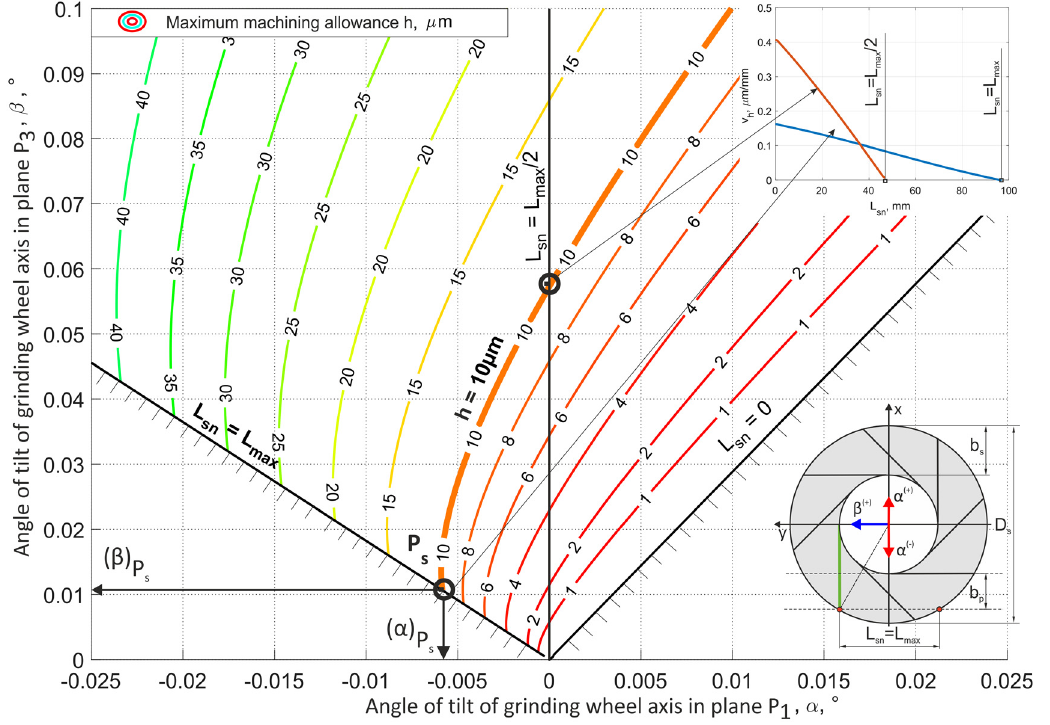
Figure 9. The values of the geometric parameters for the micro-face grinding method using a hyperboloid tool; D s = 250 mm, b s = 40 mm, b p = 30 mm.